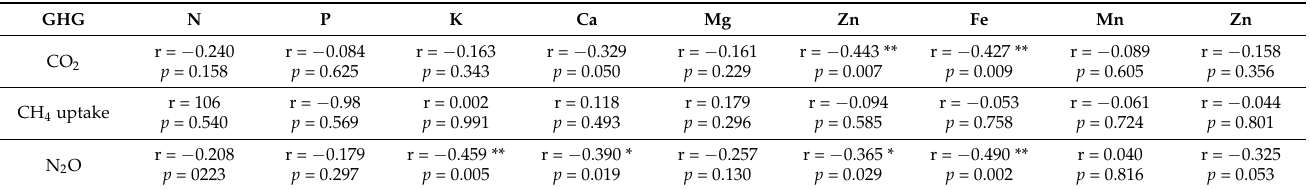
In the biplot of PCA analysis (Figure 6), the weights of the different variables (nutrients, soil GHG fluxes) are presented as arrows and vary by distance from the origin. The biplot enabled the evaluation of the correlation level among the above-mentioned quantified variables, with lines pointing in the same direction being more closely